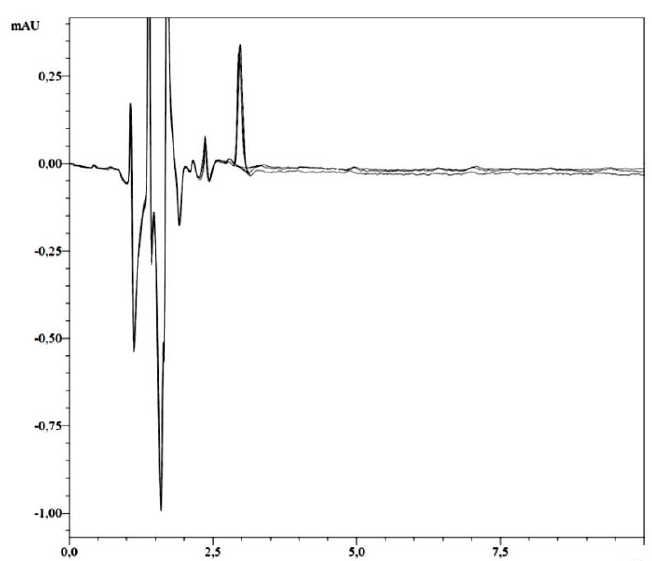
Fig. 3. Chromatograms obtained with the model solution of salbutamol 0.23 μg/ml, the peak with Rt=2.965 min corre- sponds to salbutamol